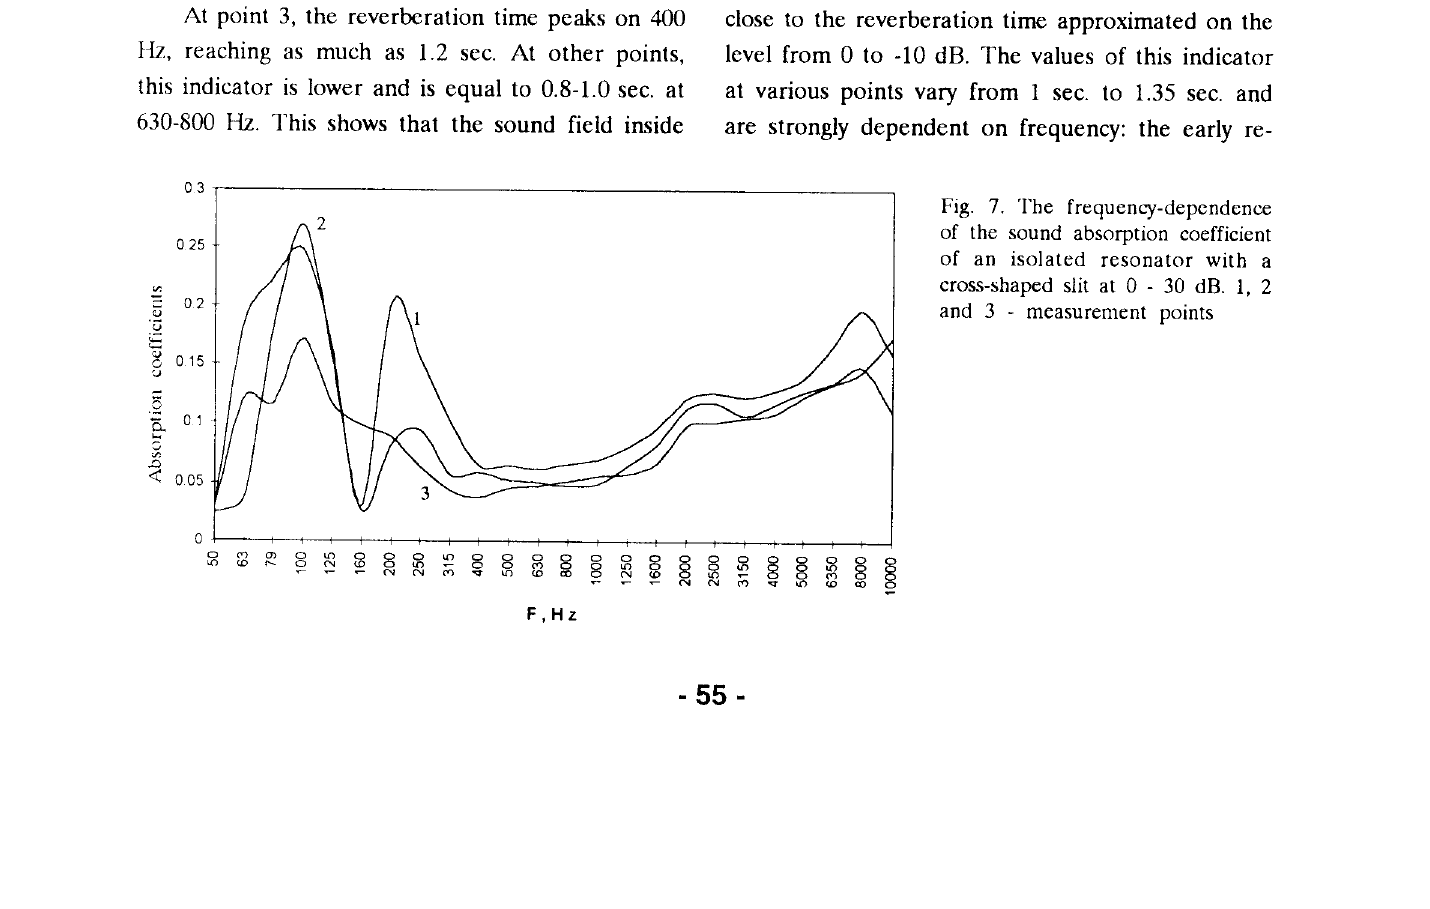
Fig. 7. The frequency-dependence of the sound absorption coefficient of an isolated resonator with a cross-shaped slit at 0 - 30 dB. 1,